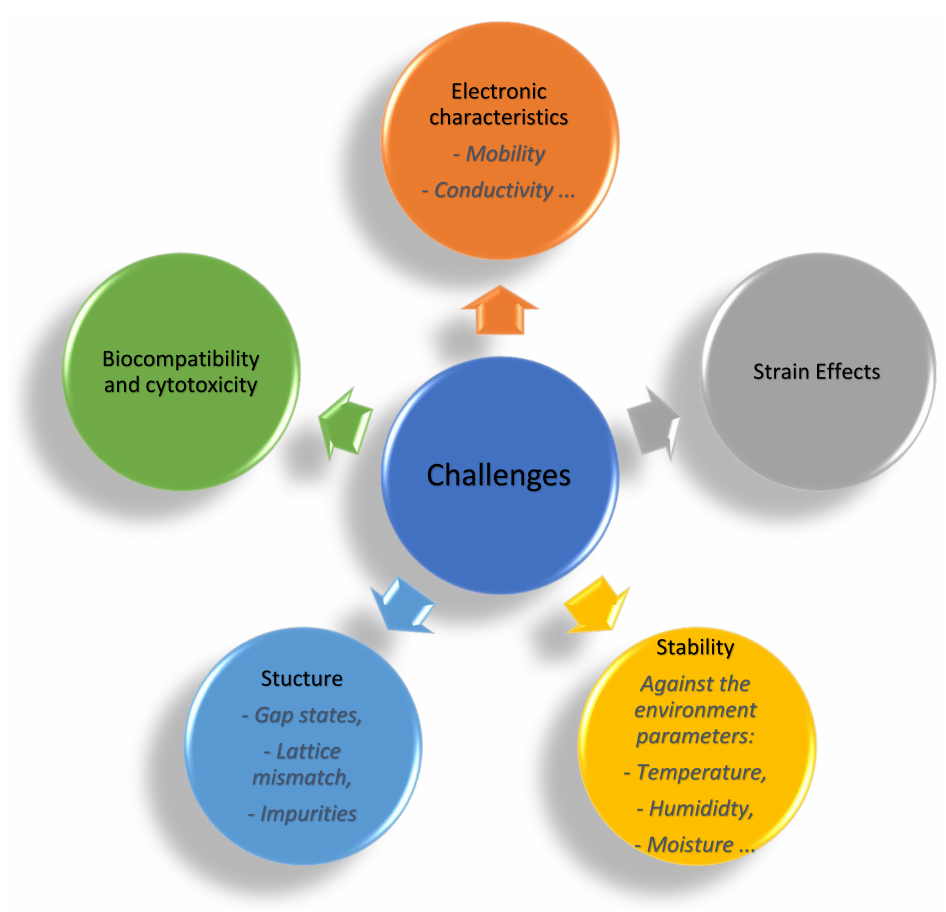
Figure 7. Illustrative diagram of challenges facing MoS 2